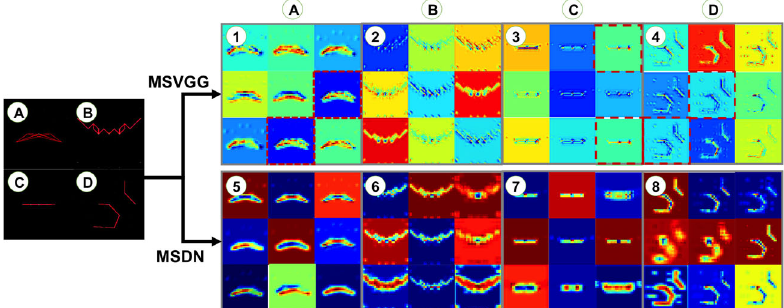
Fig. 8 Bene fi ts of the MSDN over the MSVGG in processing DP images. For selected exemplary diffraction images A, B, C, and D, the block layers of the MSVGG (1, 2, 3, and 4) and MSDN (5, 6, 7, and 8) are visualized. The third conv block of the MSVGG and the DB 2 layer of the MSDN are shown for comparison. The red dotted box indicates redundant (almost identical) feature maps. Best viewed in an electronic version.